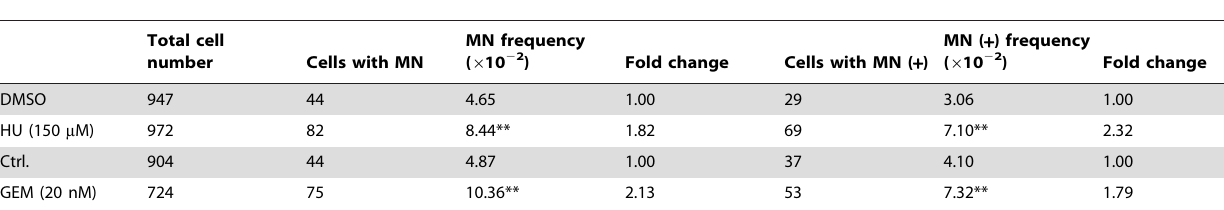
Table 2. Induction of MN and MN ( c - H2AX + ) by HU and GEM (24 hours after release).